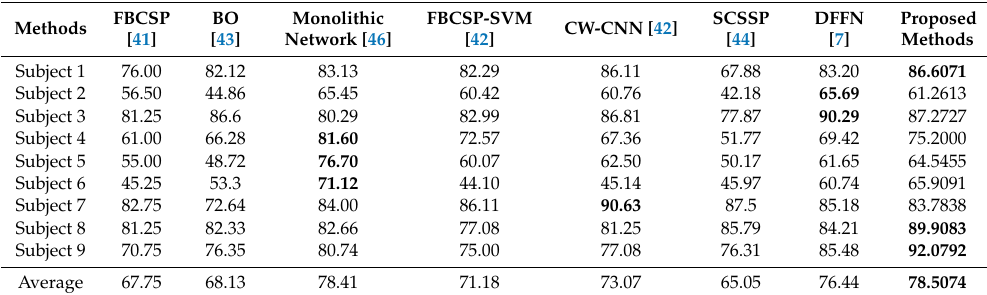
Table 2. Classification accuracy comparison with other published results applied on BCI competition IV dataset 2A. The best result for each subject is displayed in bold characters.